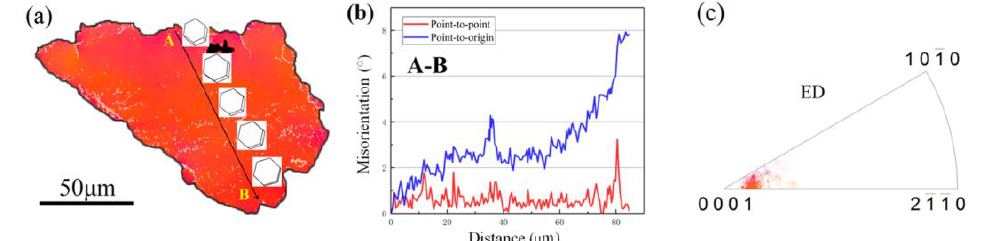
Figure 10. ( a ) Inverse pole figure (IPF) map of grain G2 containing low content LPSO phases, ( b ) line profile of the misorientation angle of the AB arrows depicted in ( a ), ( c ) IPF of the grain G2. Compared with the grain of G2, the grain of G3 containing higher content of LPSO phases showed a preferred selection for the non-basal orientation shown in Figure 11. The misorientation angle of G3 was lower than that of G2, indicating the dislocations are easily accumulated and the DDRX behavior is easier to generate.